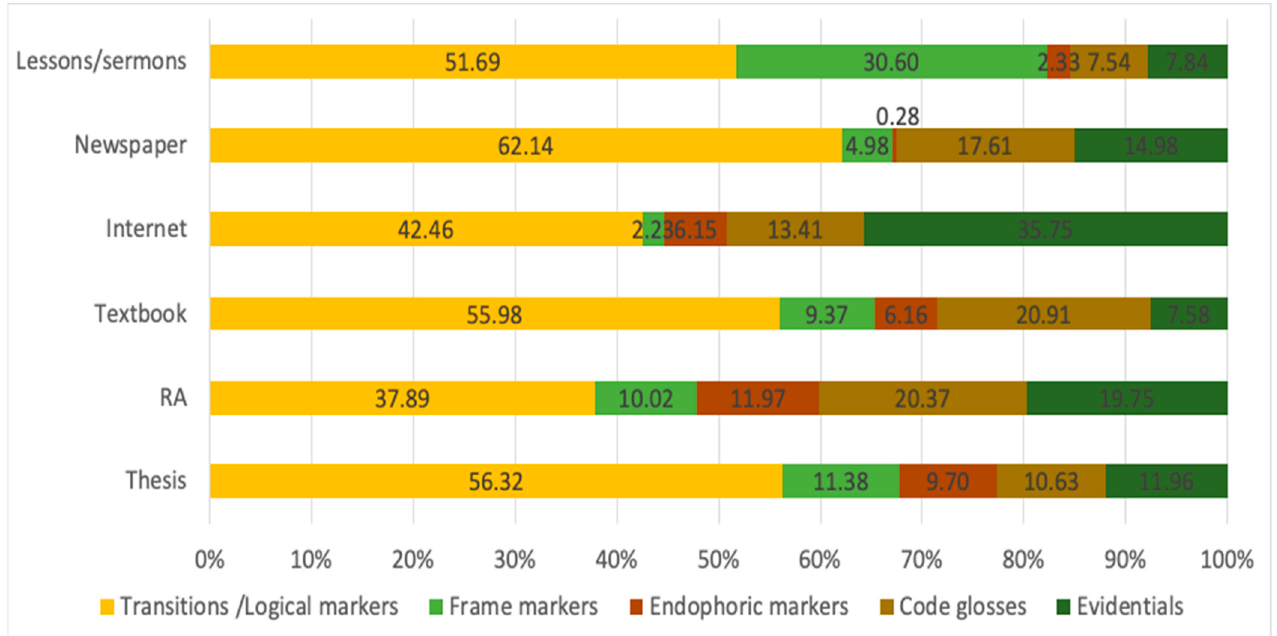
Figure 6. Average frequency of interactive markers per text type (items per 1000 words).